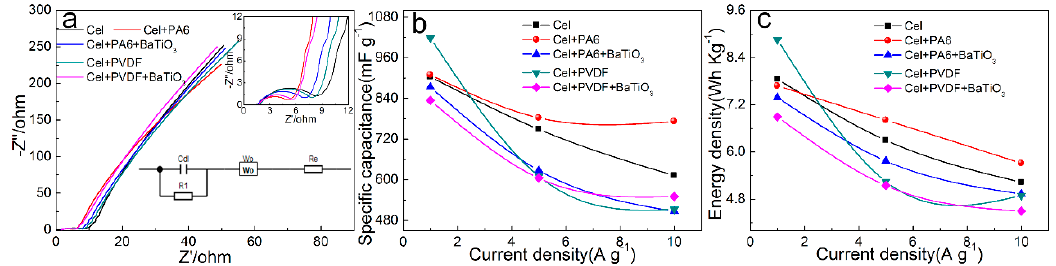
Figure 4. ( a ) EIS curve at 10 5 Hz-10 − 2 Hz and GCD curves at different current densities: ( b ) specific capacitance, ( c ) energy density.